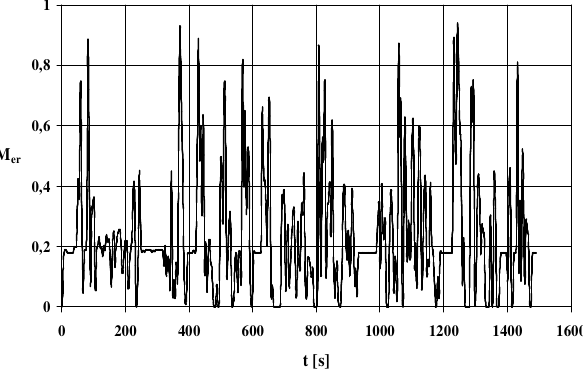
Fig. 4. Relative torque characteristic for the Malta test The average values of rotational speed and relative torque are similar for both tests – Fig. 5 and 6, while the differences occur in the case of the variation coefficient (Fig. 7 and 8) – the relative coefficient of variation of the torque for the Malta test is noticeably greater (relative dif- ference of around 0.3) – Fig. 8. Figures 9–14 show the exhaust emission intensity char- acteristics of carbon monoxide, hydrocarbons and nitrogen oxides in the NEDC and Malta tests.